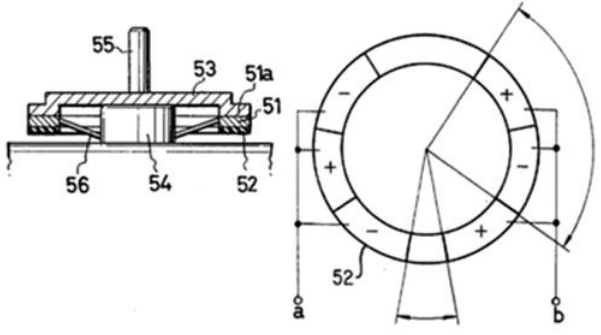
Figure 11. First commercialized ultrasonic motor proposed by Sashida [35].